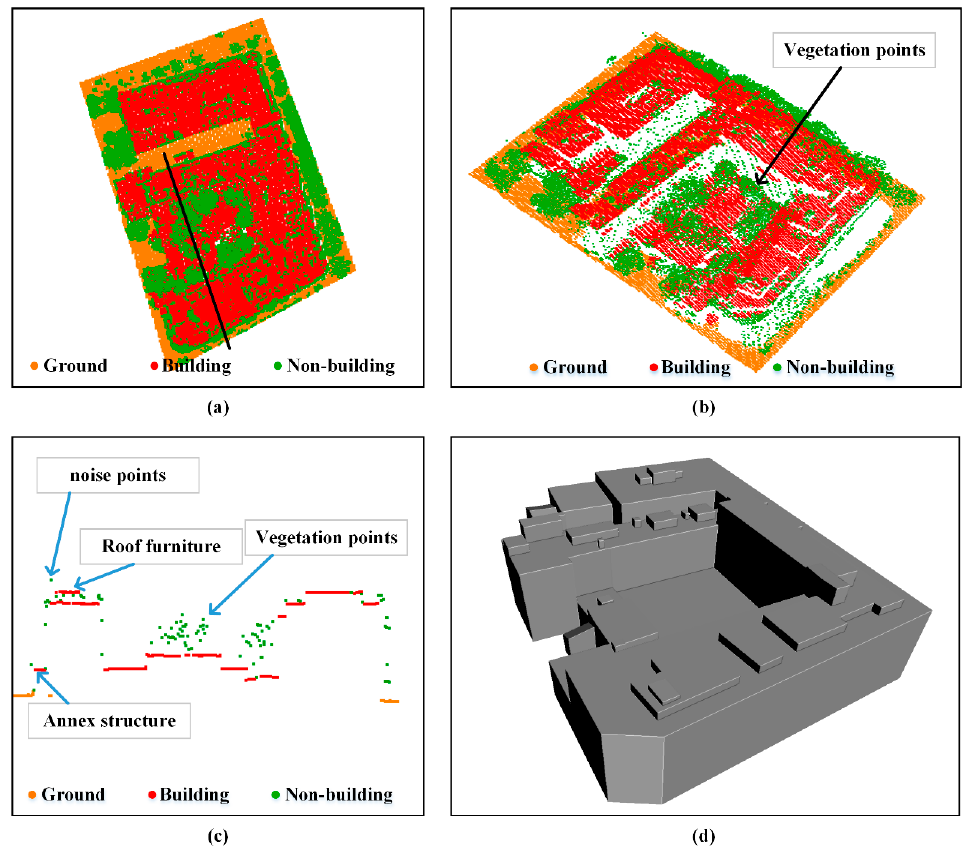
Figure 16. A result of detecting a building. ( a ) top-view of the building detection result; ( b ) side-view of the building detection result; ( c ) cross-section of the black line in ( a ) for detailed description of the building detection result, where roof furniture and annex structures are preserved, and vegetation points and noise points are removed; ( d ) corresponding building model at the scale of 0 m.